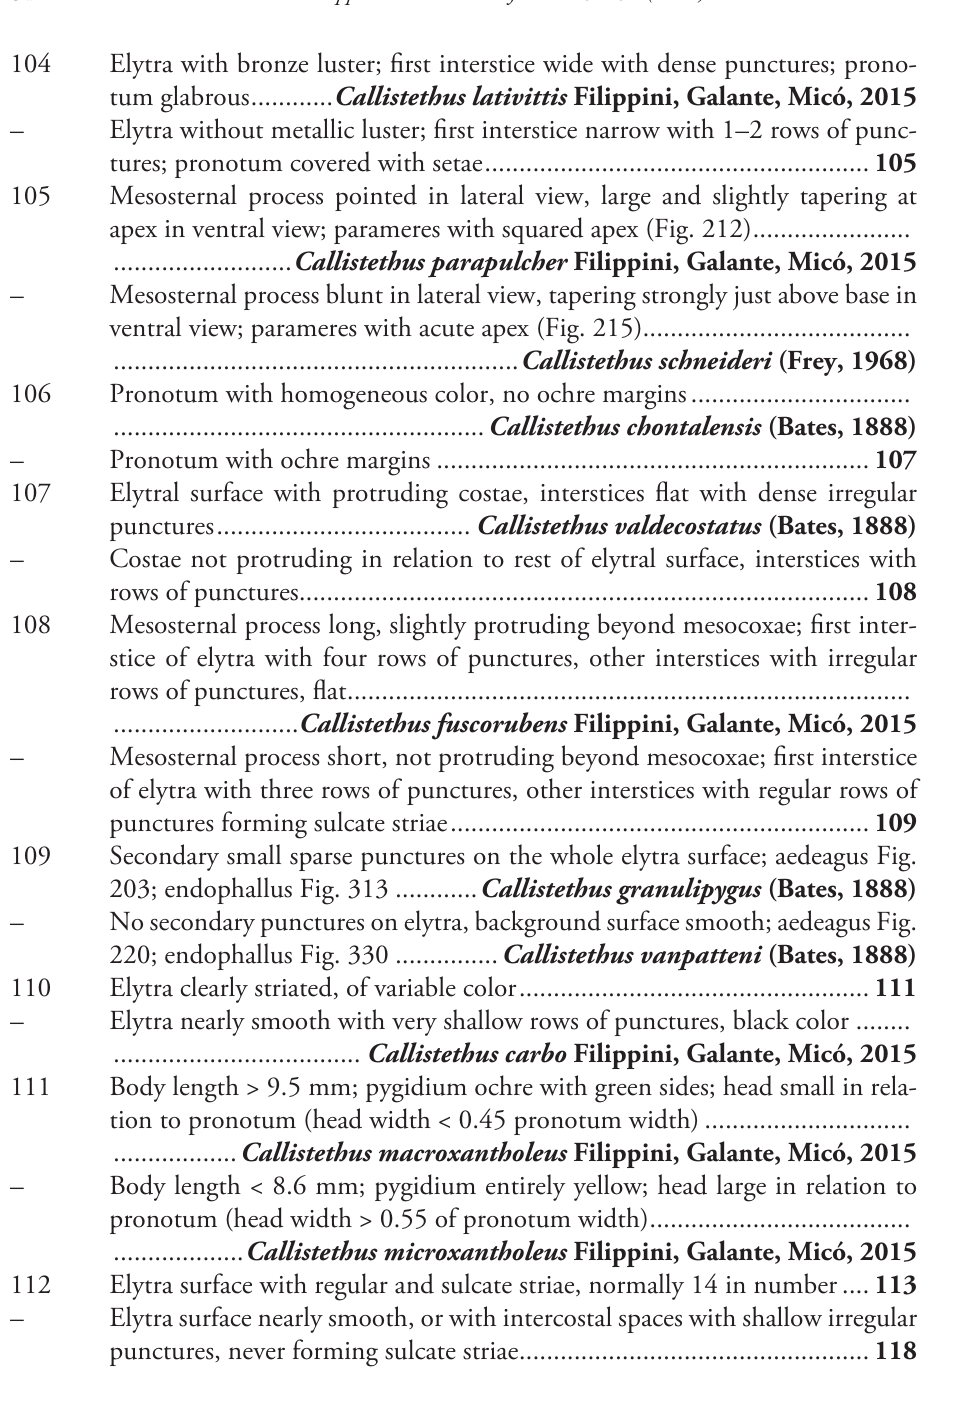
106 – 107 Elytral surface with protruding costae, interstices flat with dense irregular – Costae not protruding in relation to rest of elytral surface, interstices with 108 Mesosternal process long, slightly protruding beyond mesocoxae; first inter- stice of elytra with four rows of punctures, other interstices with irregular